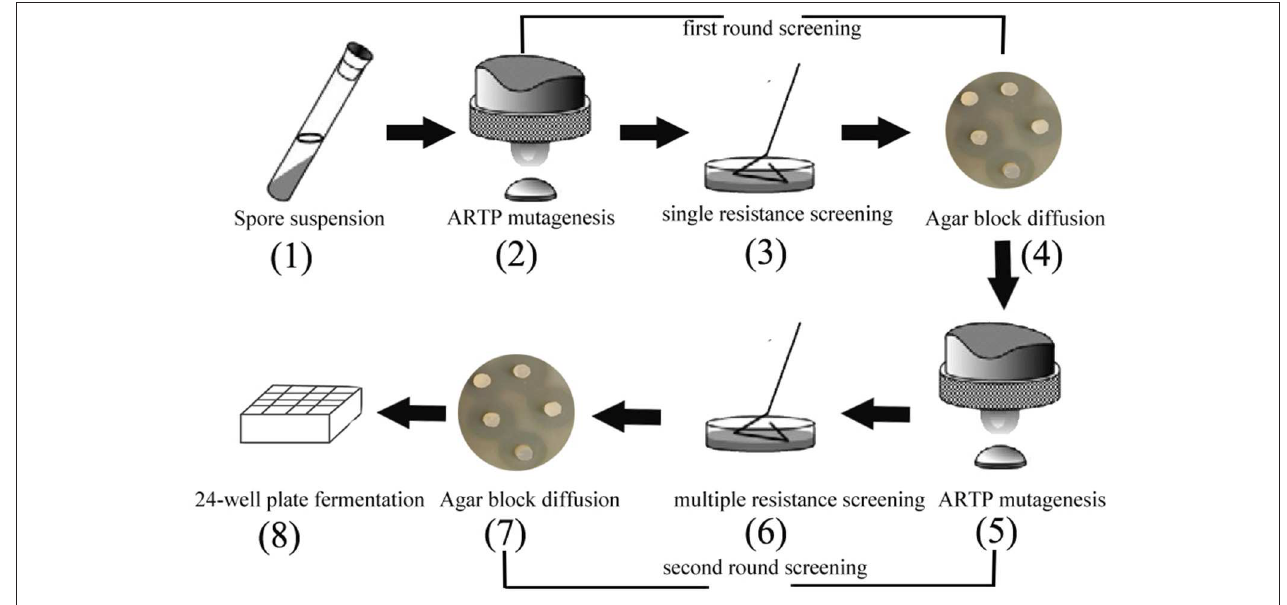
FIGURE 1 | The two rounds of resistance screening in preliminary